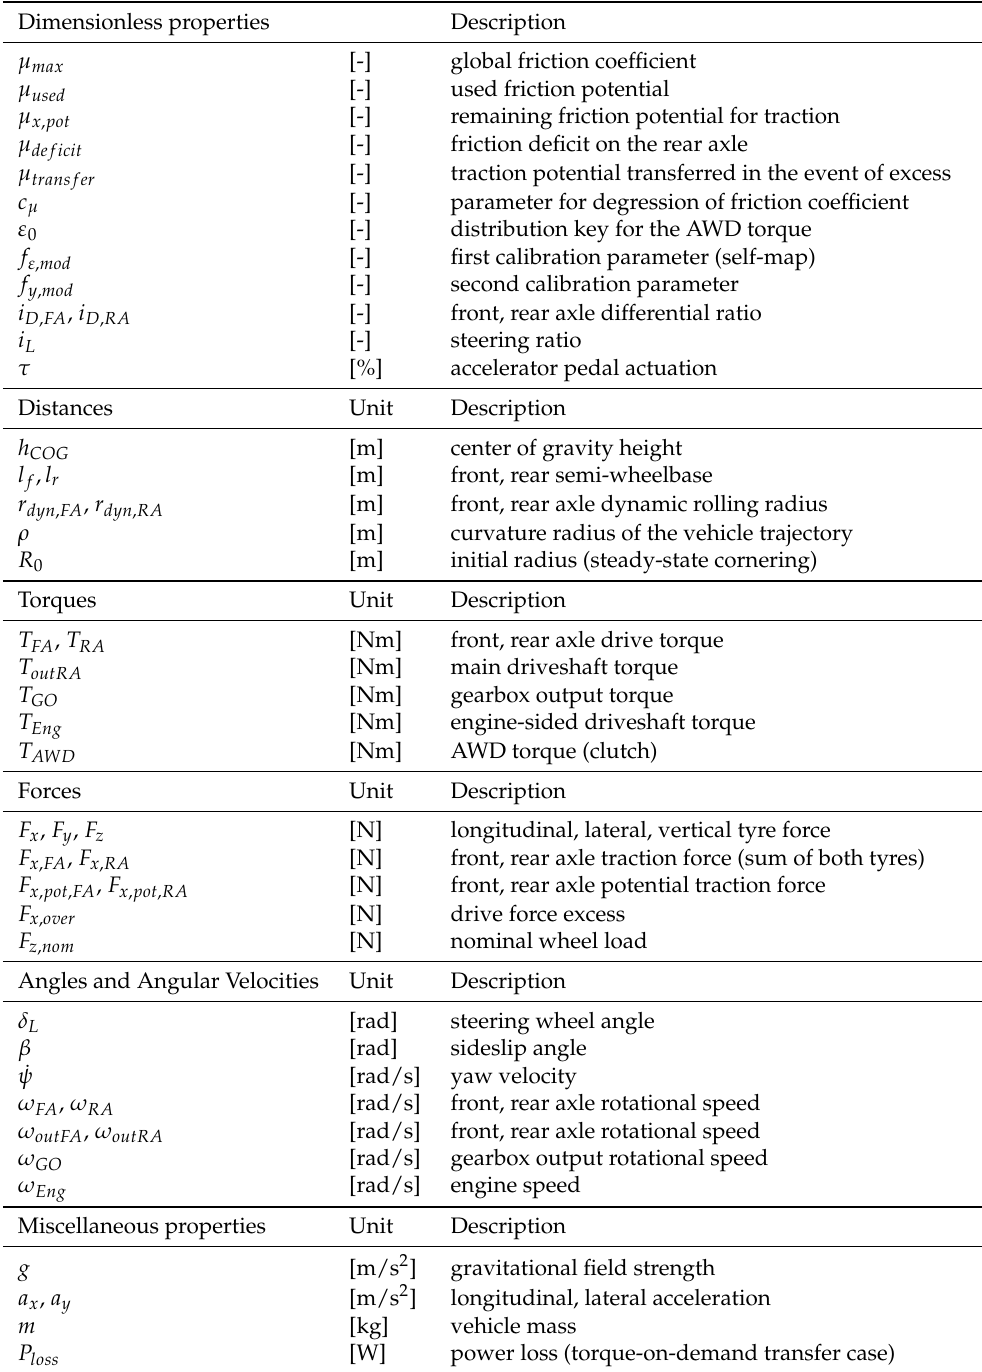
Table A1. List of symbols and